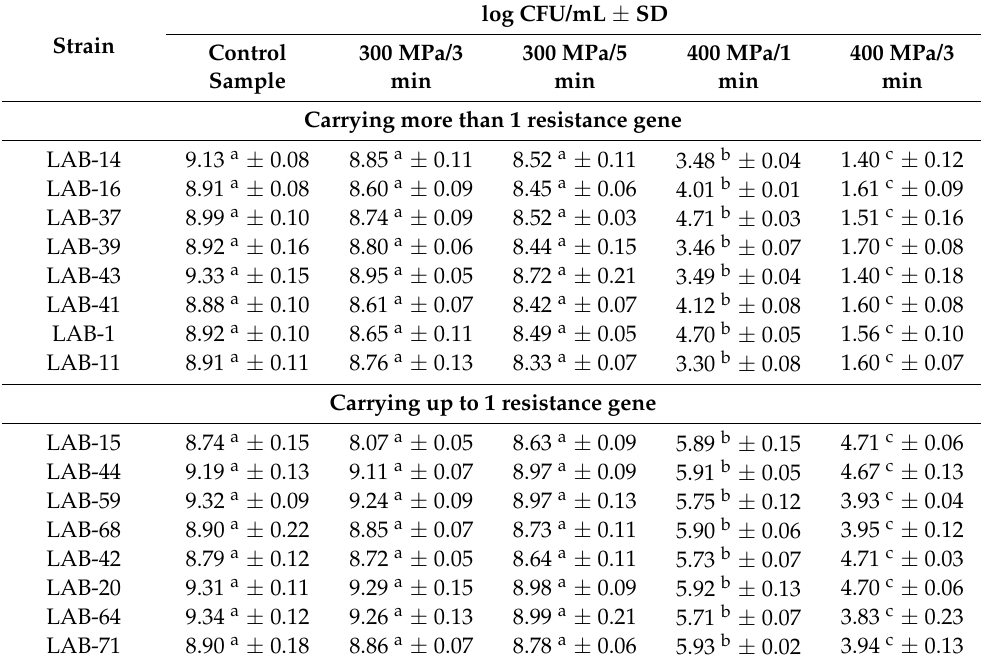
Table 4. Results of the survival analysis of strains in response to high-pressure treatment after 72 h of storage at room temperature (mean values of log CFU/mL ±